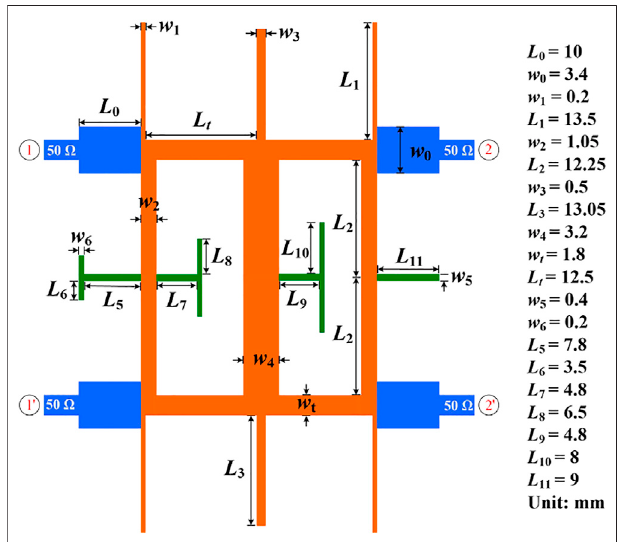
FIGURE 11 | Layout of the designed dual-wideband balanced